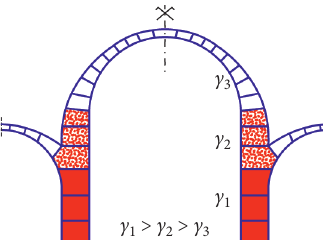
Figure 3: The scheme of favourable mass distribution (strength) and block size along height of historical building.